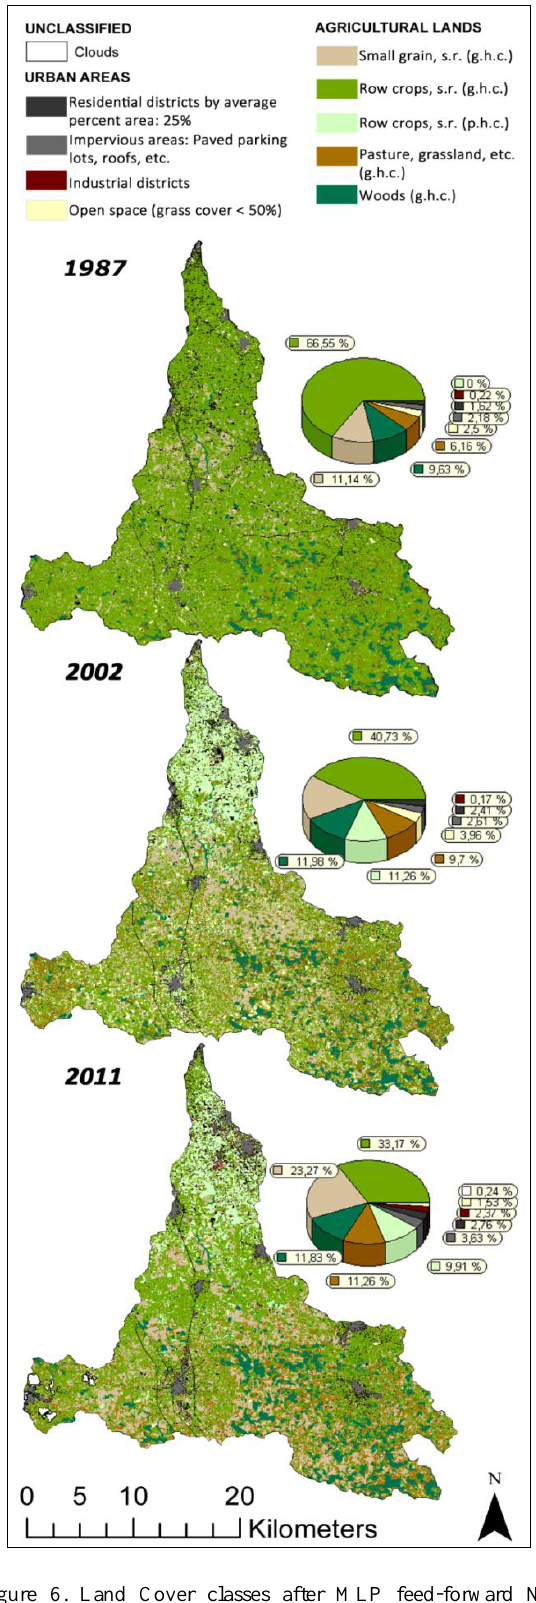
Figure 6. Land Cover classes after MLP feed-forward NN classification on the LANDSAT data subsets of 1987, 2002 and